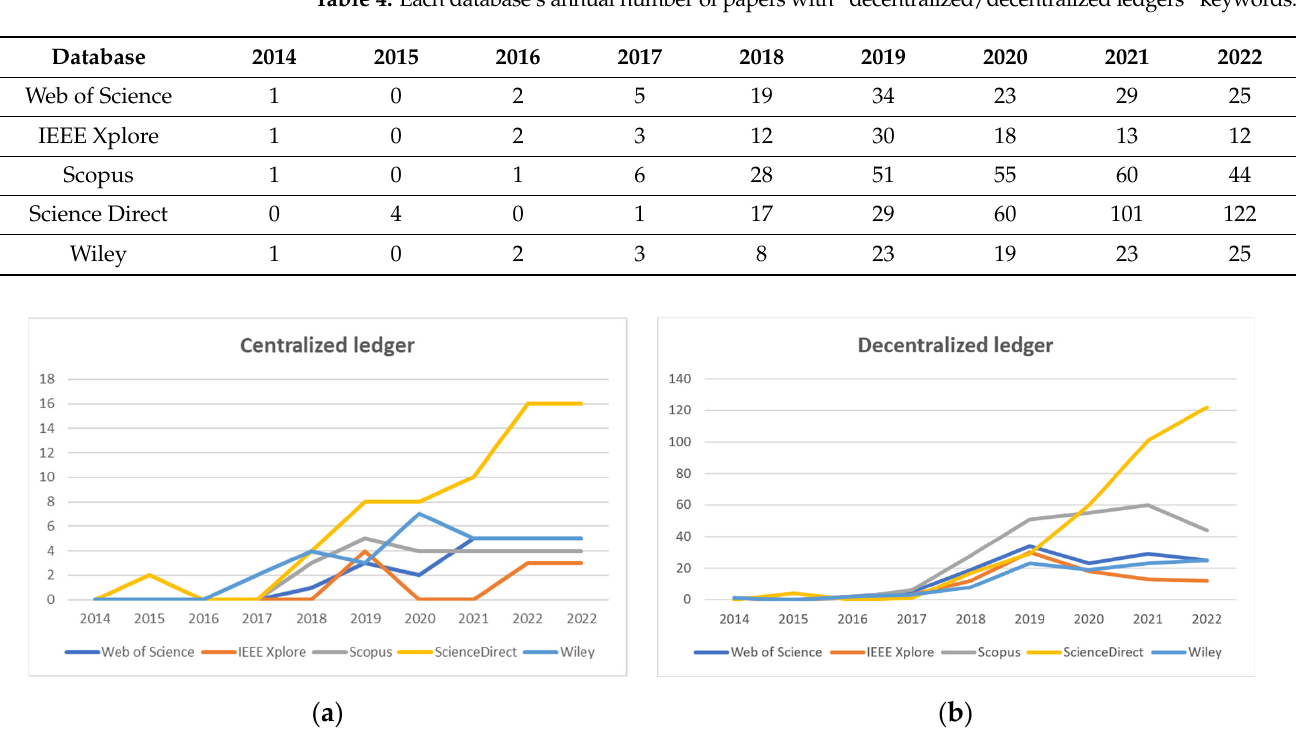
Figure 2. ( a ) Evolutionary trend in the number of publications covering centralized ledgers; ( b ) Evolutionary trend in the number of publications covering decentralized ledgers.